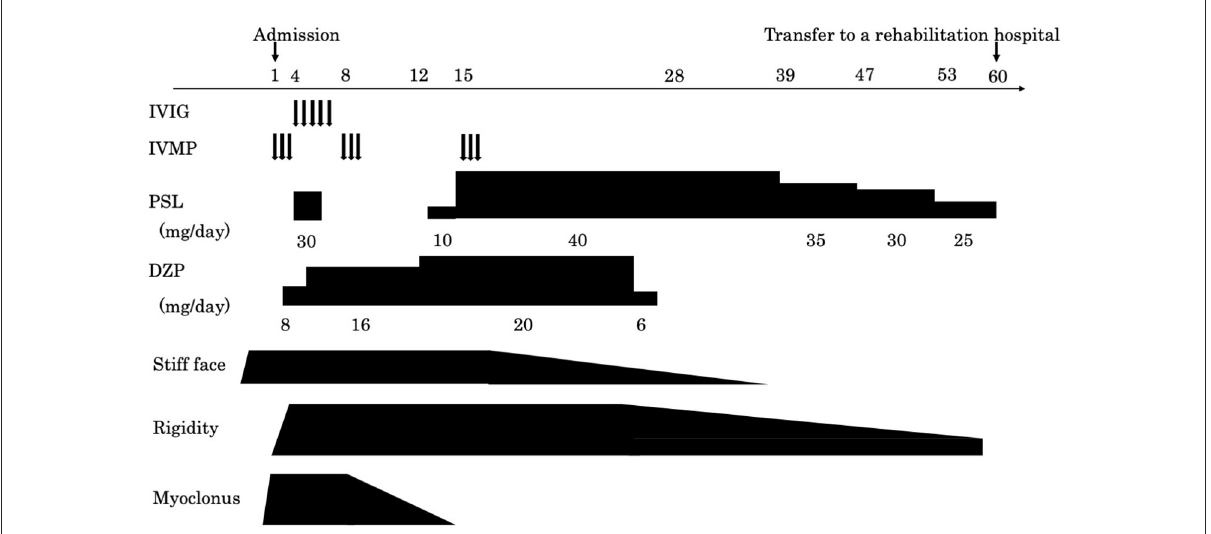
FIGURE2 A graphical summary of symptom onset and clinical management for the current case. The arrow on the left indicates the date of admission and the arrow on the right indicates the date of transfer.